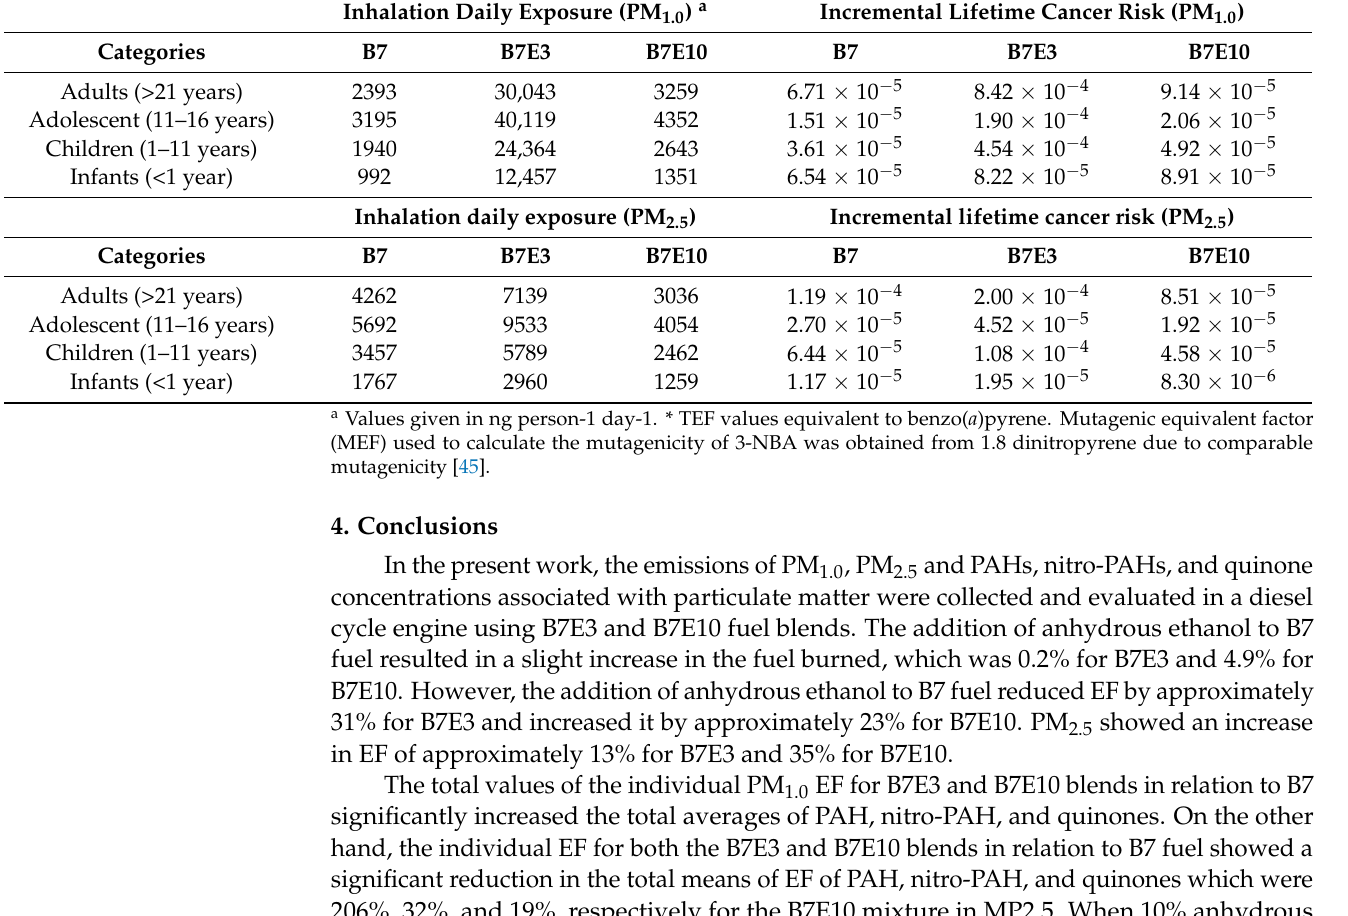
Table 6. Risk exposure by inhalation and incremental lifetime cancer risk for PM 1.0 and PM 2.5 emitted by engines fueled with diesel/ethanol blends. Data considering only the carcinogenic potential of the studied PAHs and PAH derivatives. Considering Carcinogenicity Only * Inhalation Daily Exposure (PM 1.0 )